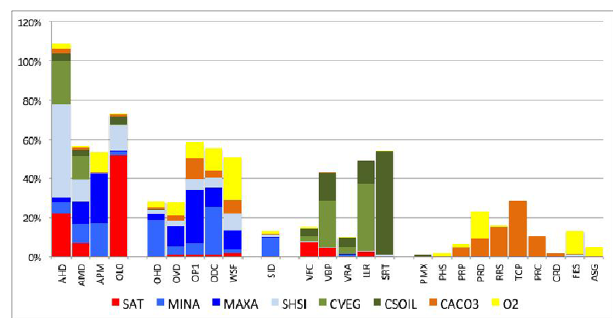
Fig. 1. Total effects for the eight plausibility emulators, normalised to total 100%. Colours identify the eight emulators. Parameters are grouped along the horizontal axis according to Earth system mod- ule (atmosphere, ocean, sea ice, vegetation and ocean biogeochem-